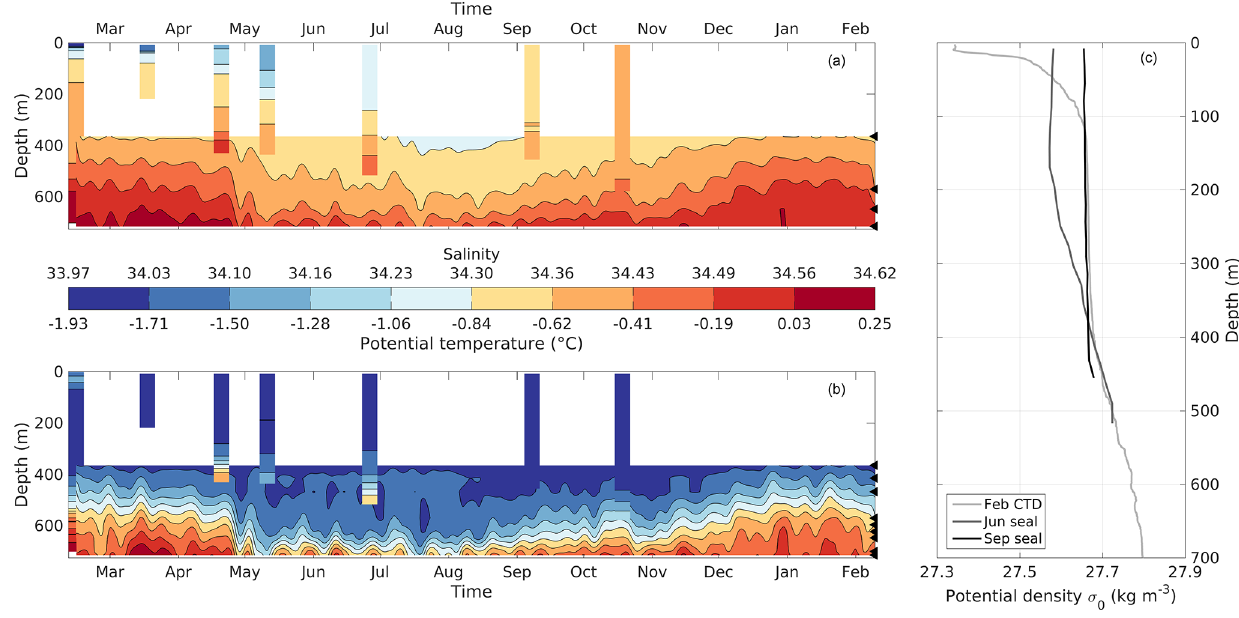
Figure 7. Hovmöller diagrams for (a) salinity and (b) temperature. The continuous records below approximately 350m depth are the hydro- graphic time series of moored instruments at M3, acquired in 2009 (see Table 1). The mooring data have been low-pass filtered by applying a fourth-order Butterworth filter removing variability at shorter periods than the cut-off period of 168h (1 week). Black triangles mark the depths of individual measurements. CTD profiles from ship (from the deployment cruise of mooring M3 in 2009; first profile) and seals (obtained in 2011 from within approximately 10km distance to mooring M3; see Fig. 1) complement the mooring records. The width of the profiles is arbitrarily set to 1 week for clarity. Panel (c) shows the seasonal development of potential density based on three of the temperature and salinity profiles near mooring